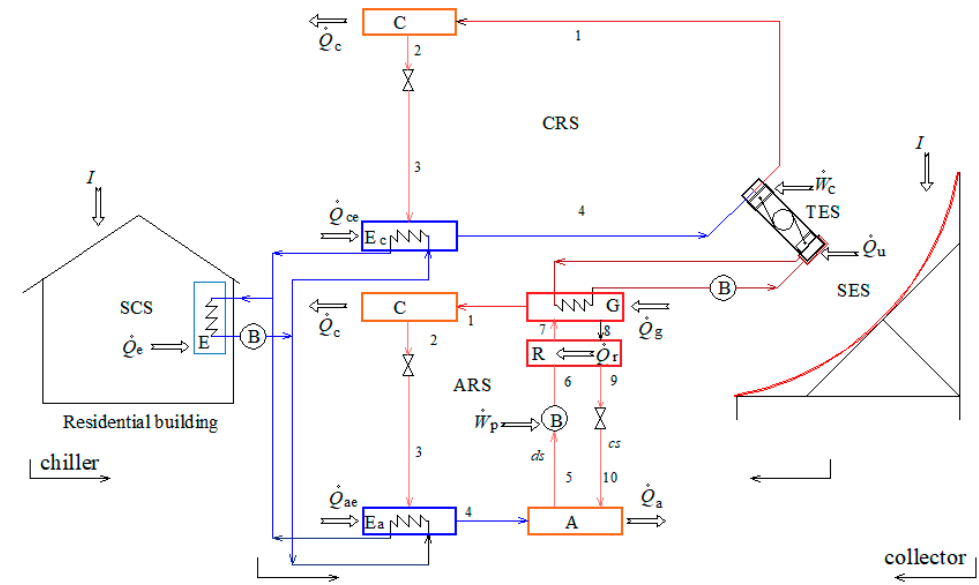
Figure 1. Schematic diagram of the hybrid compression / absorption chiller fed by Stirling engine and solar energy.